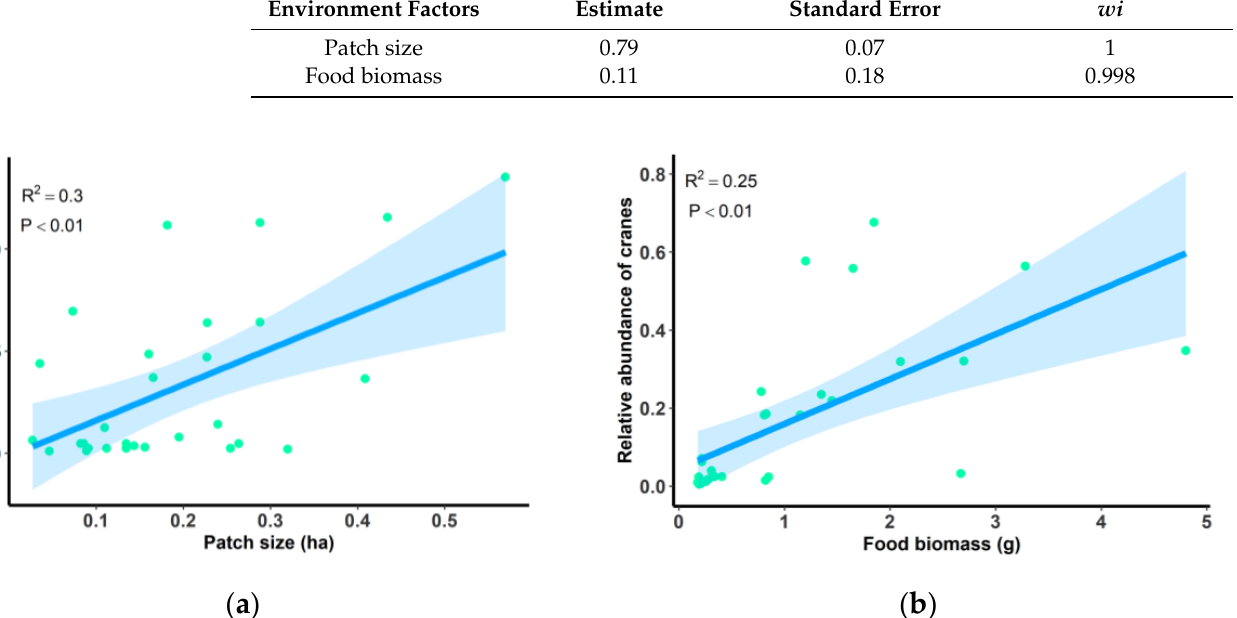
Table 2. Model-averaged parameter estimate, standard error, and relative importance (Akaike weight, wi ) for important variables.